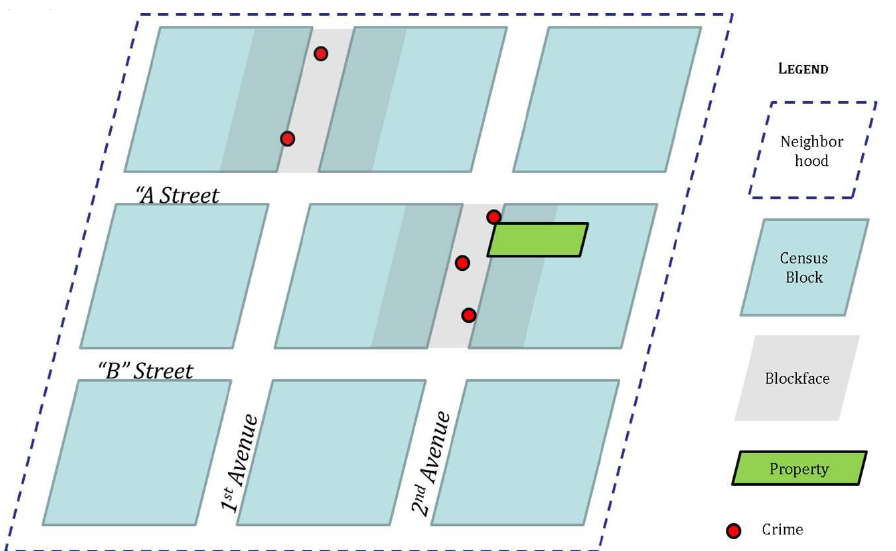
coded as residing on the same blockface, and would be coded as exposed to the same incidents of